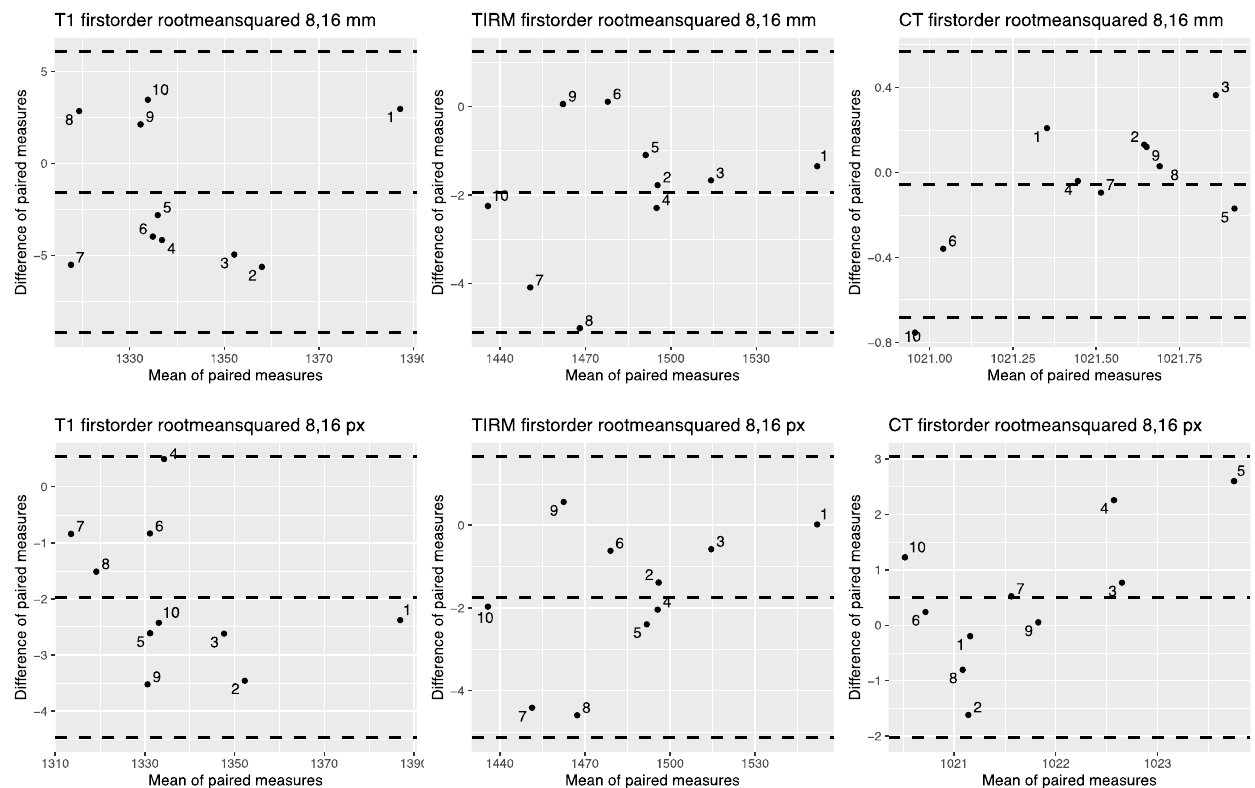
Figure 6. Bland–Altman plots for the first-order feature root mean squared for pixel-sized and mm-sized ROIs from CT and MR images. Bland–Altman plots for T1w MR images on the left, for T2w TIRM images in the middle, and for CT-derived images on the right side. The upper row shows root mean squared extracted from mm sized ROIs, the lower row root mean squared extracted from px sized ROIs. Bland–Altman plots for all features are shown in the Supplementary Materials (see Figures S5).